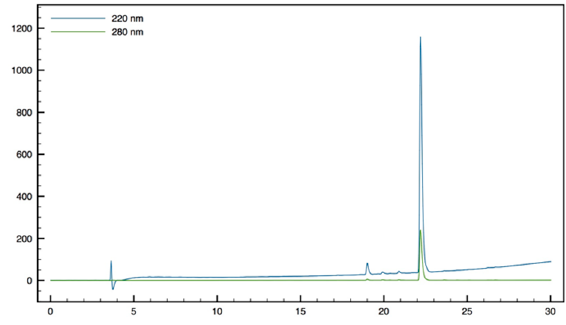
Figure 21. HPLC profile of Np-Tbt- β 2,2 h bis-Orn-OMe 19 Figure 21 . HPLC profile of Np-Tbt- β 2,2 h bis-Orn-OMe 19 .